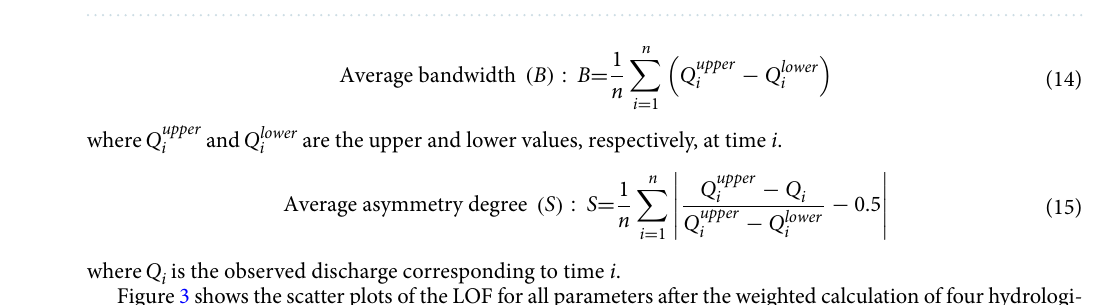
Figure 3. Scatter plots of likelihood objective function values for each parameter. The figure was generated by MATLAB2019a (https:// www. mathw orks.